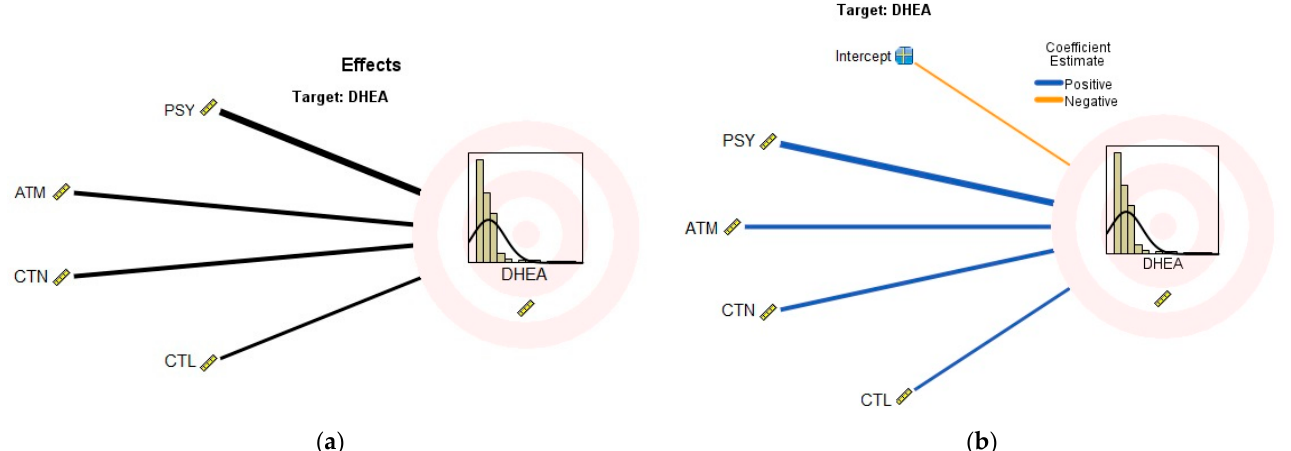
Figure A3. The forward stepwise model selection method results presented for Model 3 after automatic linear modelling: ( a ) the identified effects for the predictors on dehydroepiandrosterone levels (DHEA) by psychological (un)safety in the group (PSY), attitude towards the military service (ATM), cortisone (CTN), and cortisol (CTL) and ( b ) the negative and positive coefficient estimations that were identified in Model 3 for psychological (un)safety in the group (PSY), attitude towards the military service (ATM), cortisone (CTN), and cortisol (CTL).